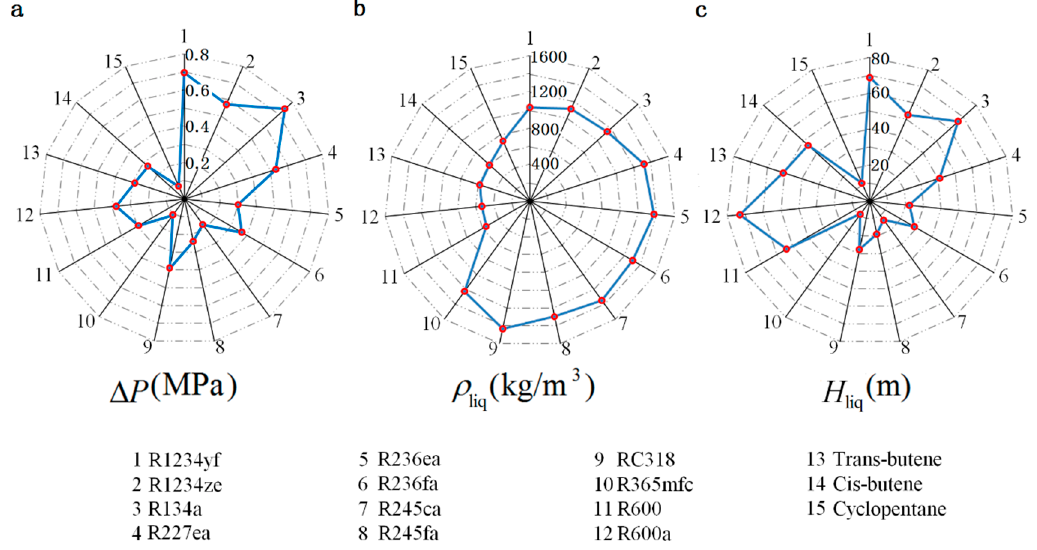
Figure 12. Parameters comparison for each fluid. ( a . difference between saturated pressure at 62 ◦ C and saturated pressure at 40 ◦ C; b . saturated liquid density at 40 ◦ C; c . fluid liquid column